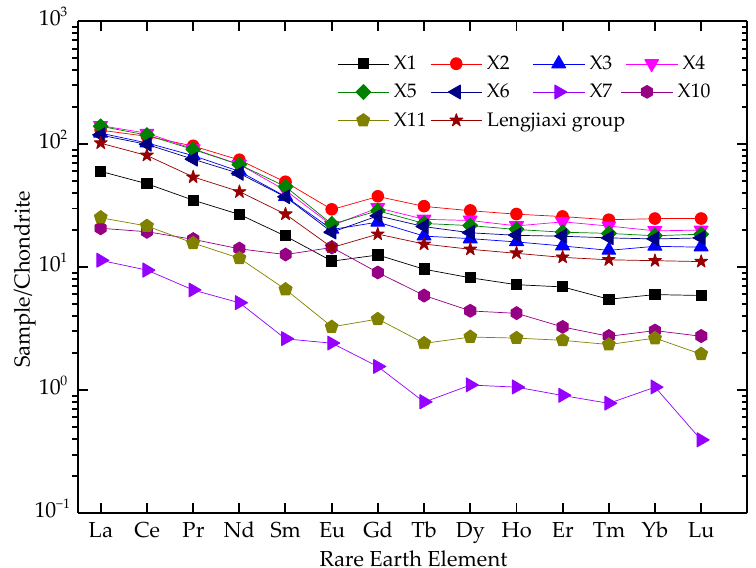
Figure 5. Chondrite-normalized REE distribution patterns of hosted rocks and ore. (Lengjiaxi Group modified after [39]).